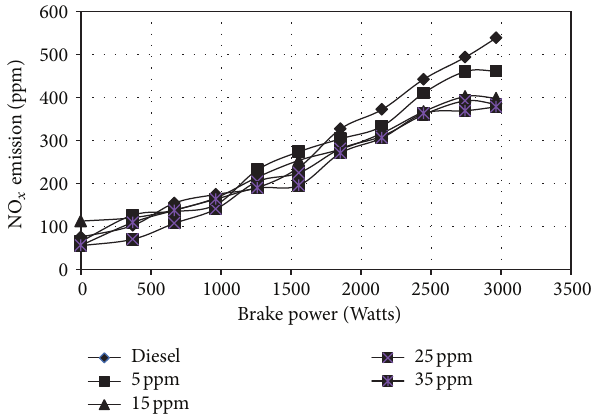
Figure 12: Variation of NO 𝑥 emissions with load for diesel and modified